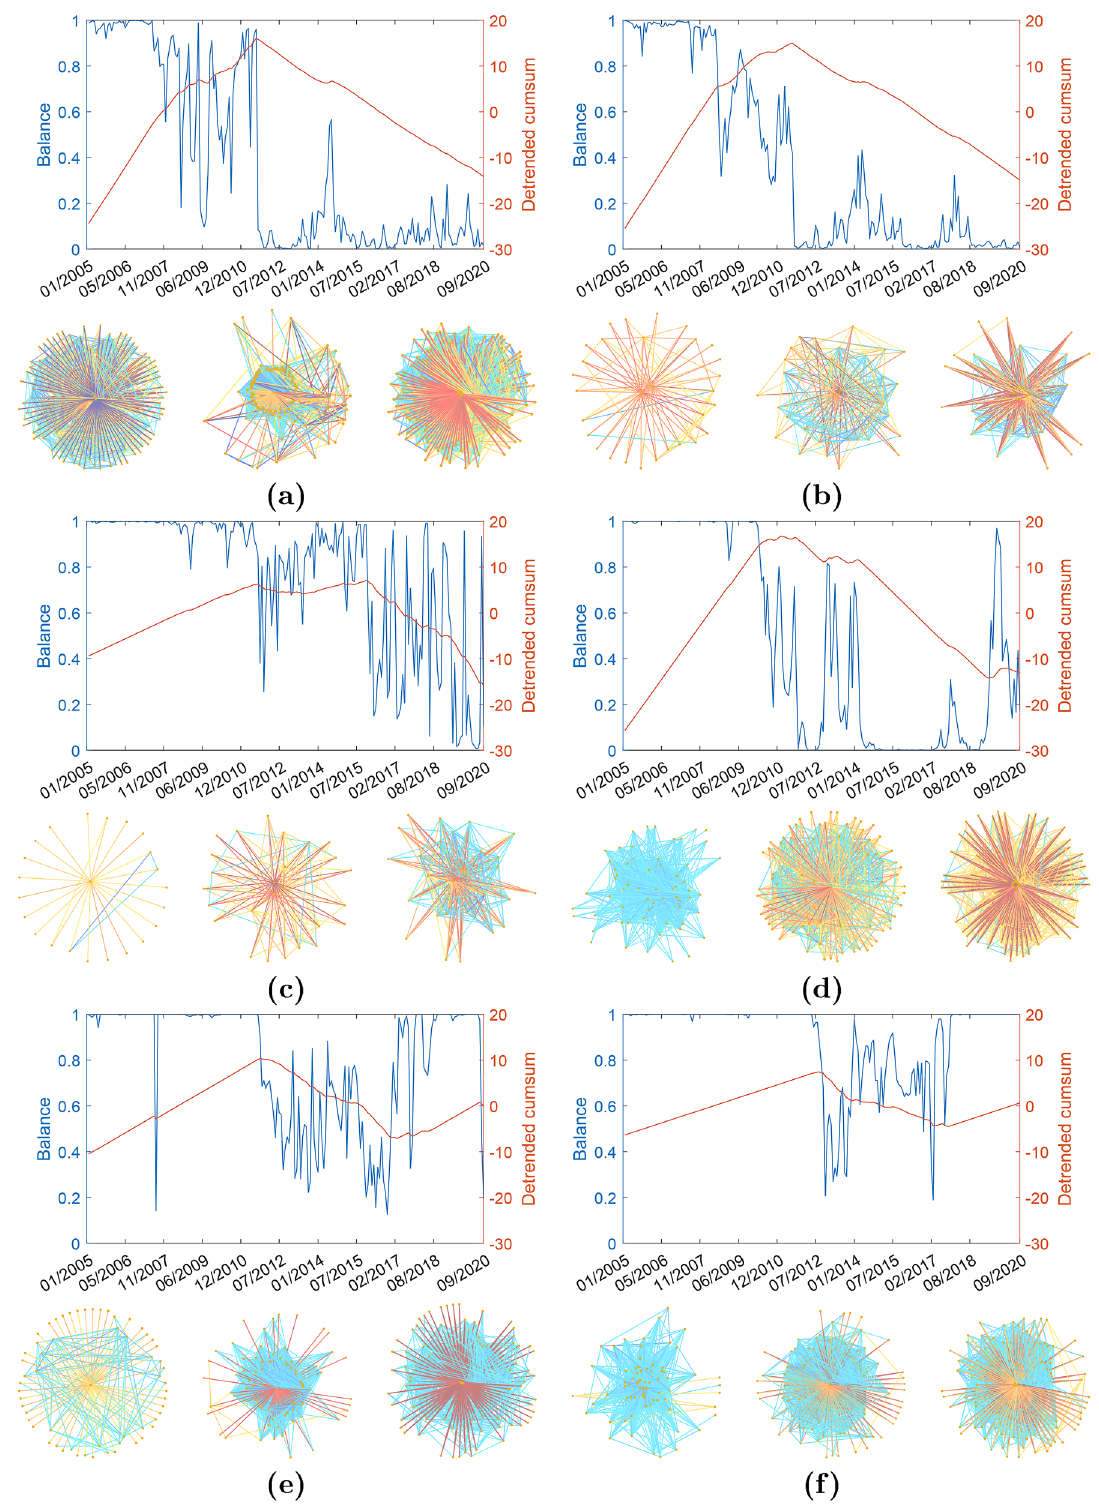
Figure 2. Balance degree evolution. ( a ) The US. ( b ) Portugal. ( c ) Ireland. ( d ) Greece. ( e ) Spain. ( f ) France. (Top panels) Illustration of the evolution of the balance for the period between January 2005 and September 2020 in the WSSN (blue line) and of its detrended cumulative sum (red line). (Bottom panels) Illustration of three snapshots of representative networks at different times (before, at, and after the BUT). The WSSNs are illustrated using the degree of the nodes as a proxy for the location of the nodes. The most central nodes are at the centre and the low degree nodes are located at the periphery of the graph. The colors of the edges correspond to the Kendall’s tau estimates, with links going from dark red for the most negative to blue for the positive ones. In the Supplementary Information we provide Matlab images of all the networks displayed in the figure where node labels are incorporated. The reader can zoom in these networks for